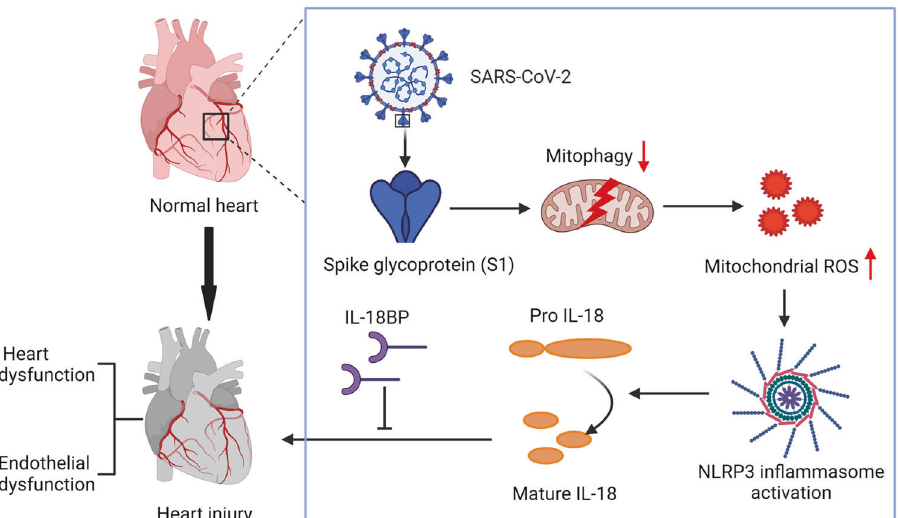
Fig. 9 Model illustrating the associations between SARS-CoV-2 signaling, mitophagy inhibition, IL-18 activation, and heart injury. Upon infection, Spike protein can inhibit mitophagy and induces mitochondrial ROS production, thus leading to in fl ammasome activation, IL-18 maturation, and the occurrence of heart injury. The schematic illustration was designed by